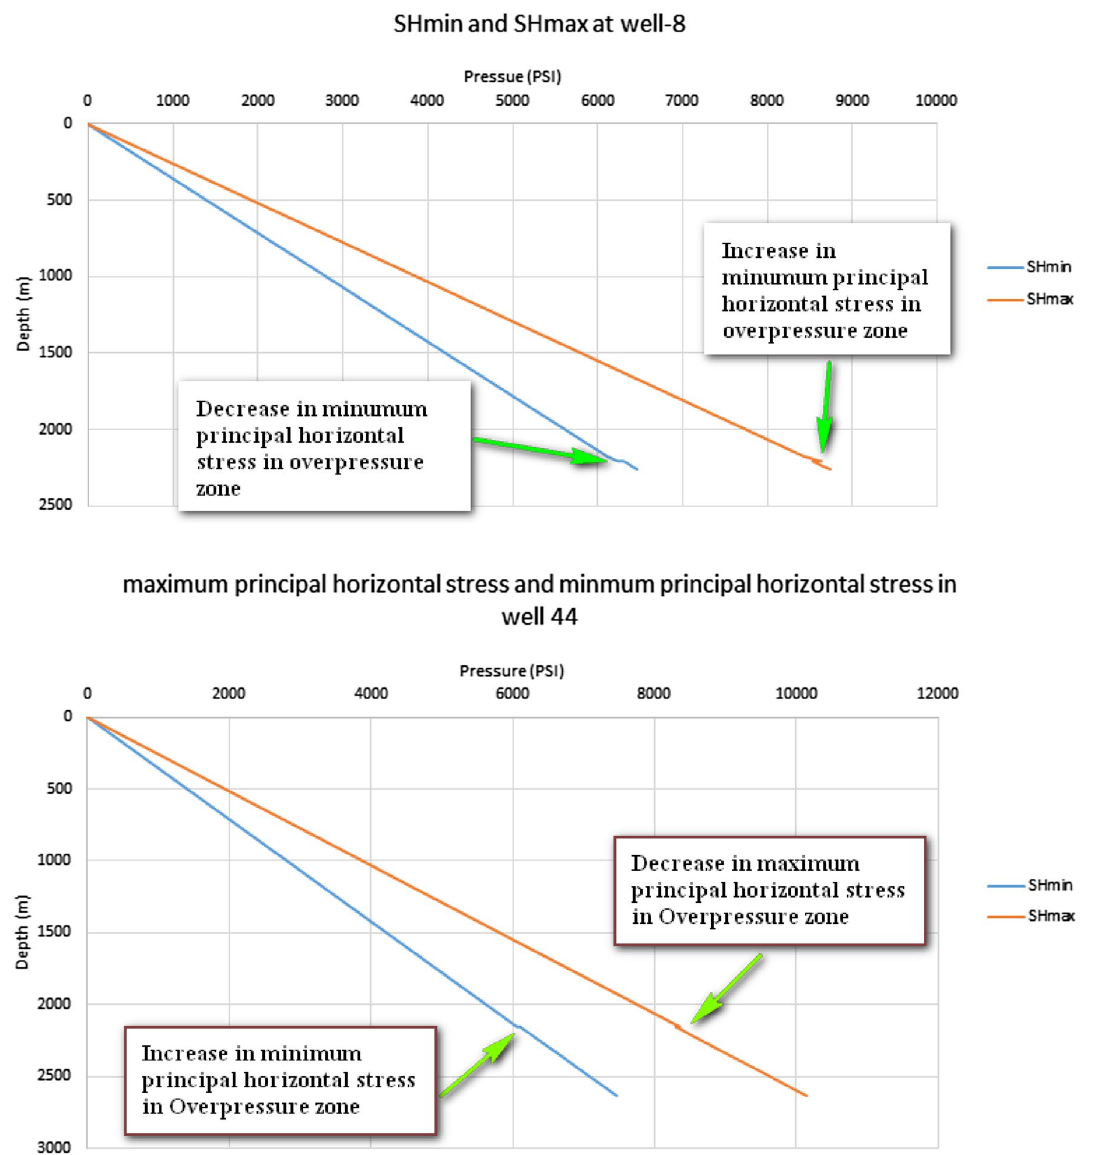
Determination of the mud density using a pore pressure gradient The mud density can be determined by dividing the pressure gradient to 0.052 (Zoback 2007). Figure 10 indicates the graph of mud density (in ppg) for the studied well. This figure indicates that up to a depth of 2200 m, the well can be drilled with a mud density of about 8.33 ppg. However, in the overpressure interval the mud density should be increased to a value of 8.81 ppg in order to avoid formation